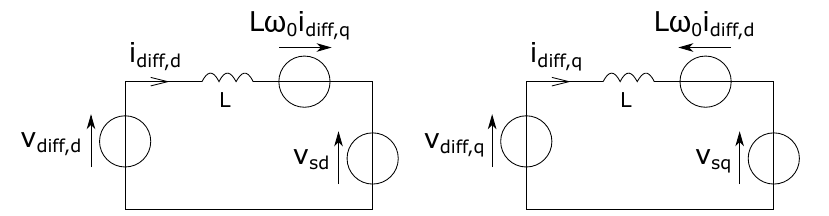
Figure 6. Equivalent circuits of the converter in the dq plane, for output-current